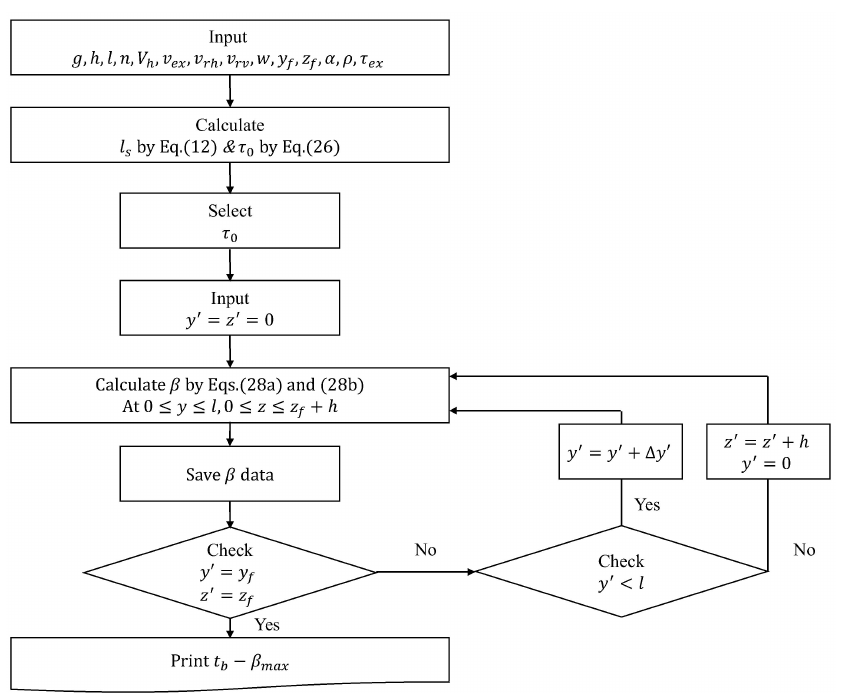
Figure 10. Computational procedures to calculate τ 0 , β max